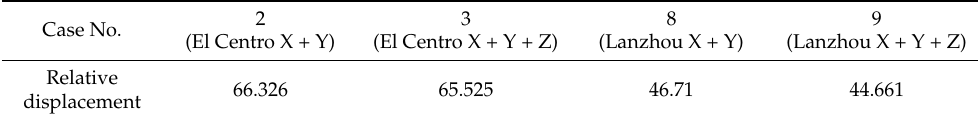
Table 7. Relative displacements of piers 2 and 4 in the transverse direction of the bridge (mm). Case